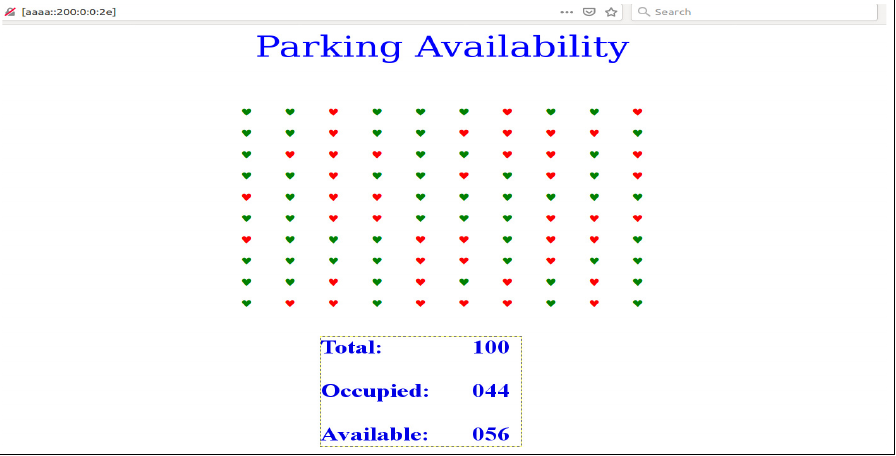
Figure 5. Over-the-Internet data consumer, a web browser showing parking